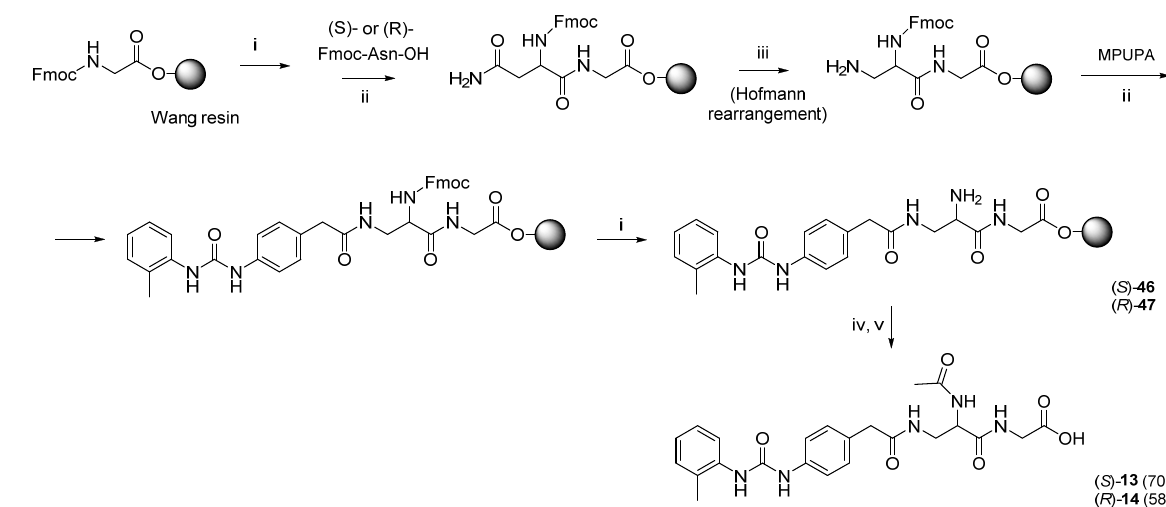
Table 1. Inhibition of α 4 β 1 integrin-mediated Jurkat cell adhesion a to plates coated with the en- dogenous ligand FN (10 μ g/mL) by the reference compounds BIO1211 and DS-70 ( 6 ), and by the new hybrid peptides 7 - 14